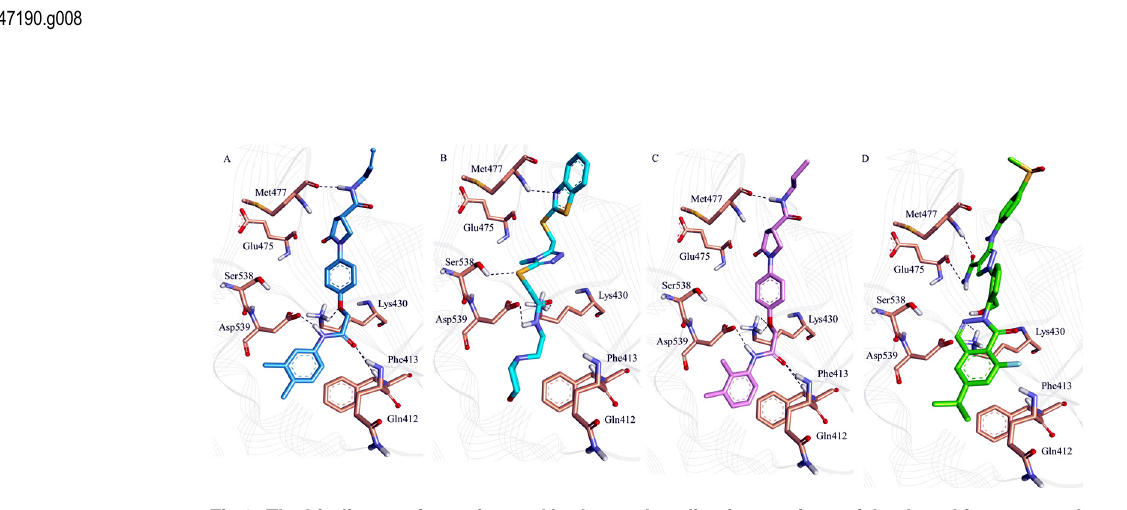
Fig 9. The binding conformation and hydrogen bonding interactions of the three hit compounds and reference inhibitor in the active site of Btk. (A) Hit1: blue (B) Hit2: cyan (C) Hit3: pink and (D) Inhibitor: Green. Hydrogen bond interactions between proteins and compounds are shown as black dotted line. Only polar hydrogen atoms are shown for